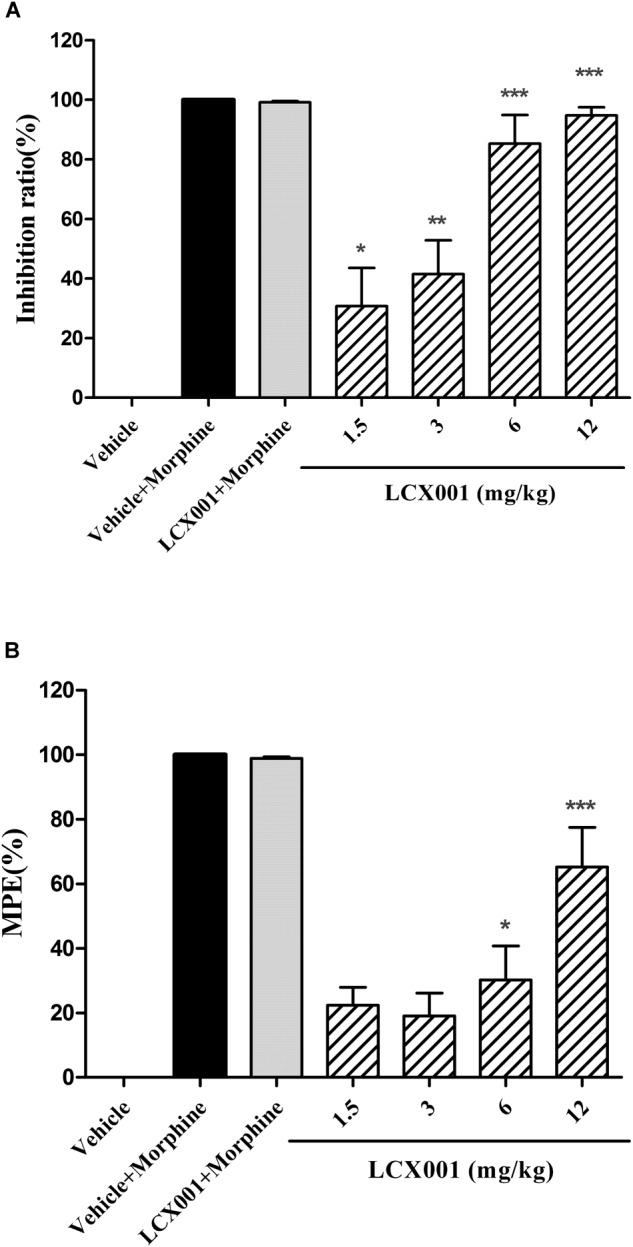
Anti-nociceptive effect of LCX001. Morphine (2.5 or 10 mg/kg, s.c.) was used as positive control drug. (A) Effect of LCX001 in the writhing test. 10 min before 0.6% acetic acid treatment, LCX001 administration (1.5, 3, 6, and 12 mg/kg, i.v.) significantly inhibited acetic acid-induced writhing compared to vehicle (20% HPCD, i.v.); mean ± SEM, each group contained 10 male KM mice. (B) Effect of LCX001 in the hot-plate test. LCX001 at 6 and 12 mg/kg (i.v.) markedly increased %MPE after the hot-plate stimulation as compared with the vehicle control group. ∗Significant difference by one-way ANOVA, Dunnett’s test (LCX001 treatment groups vs. vehicle control group;∗P < 0.05, ∗∗P < 0.01 and ∗∗∗P < 0.001); mean ± SEM, each group contained 10 female KM mice.